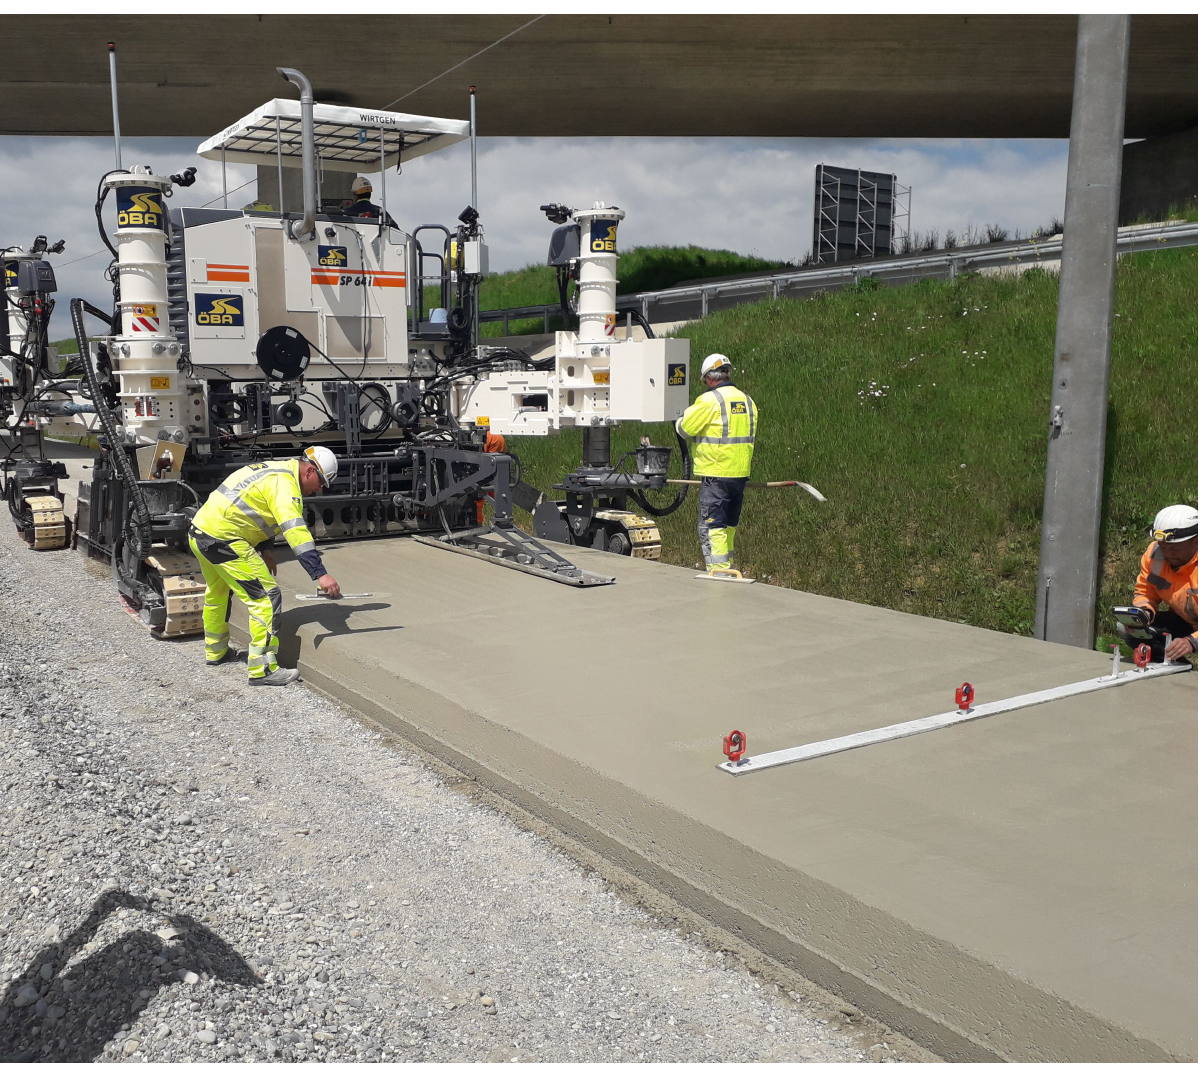
Figure 2. Machine laying by finisher of the hydraulically bound layer under the top concrete slab (HGT), Photography author: DB Projekt Stuttgart-Ulm GmbH/Ondřej